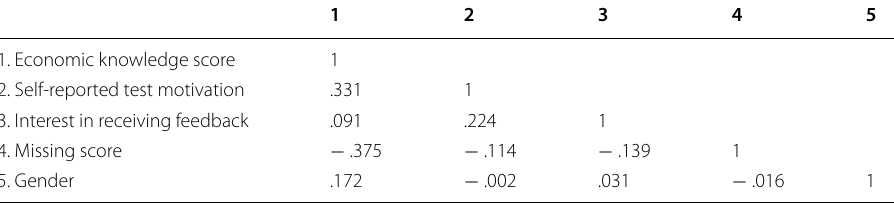
Table 4 Estimated correlation matrix for the latent